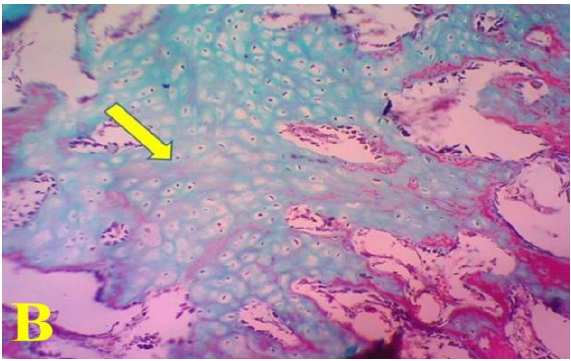
Figure, 3: In the third group at the sixth week, shown presence of fibrocartilaginous tissue with few amounts of fibrous tissue (arrow) in the fractured bone gap. A: H&E X40, B: Masson trichrom